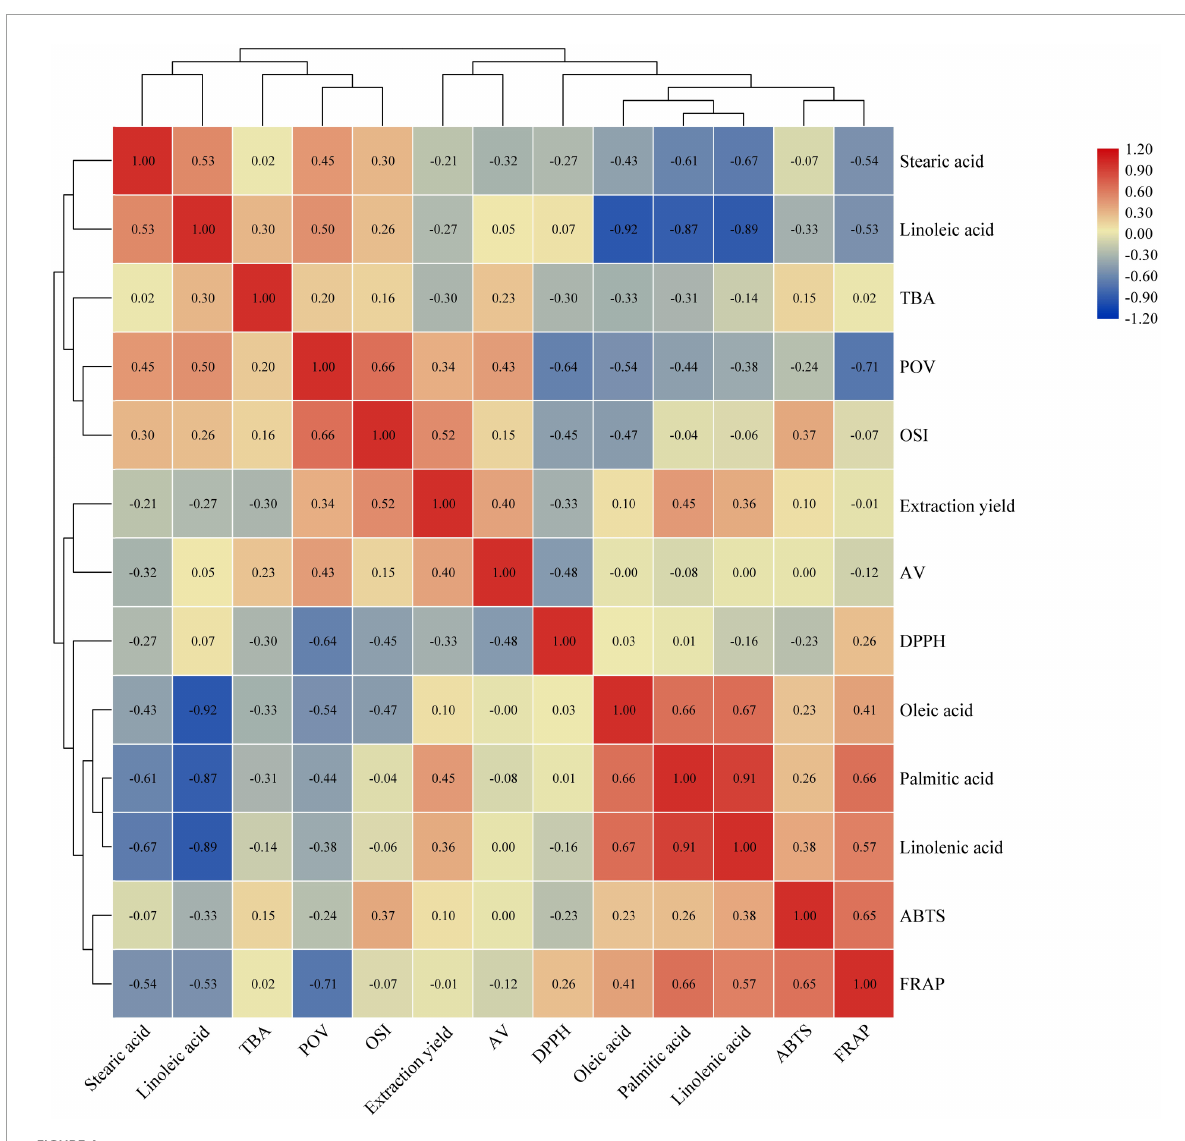
FIGURE4 Correlation heatmap between walnut oil